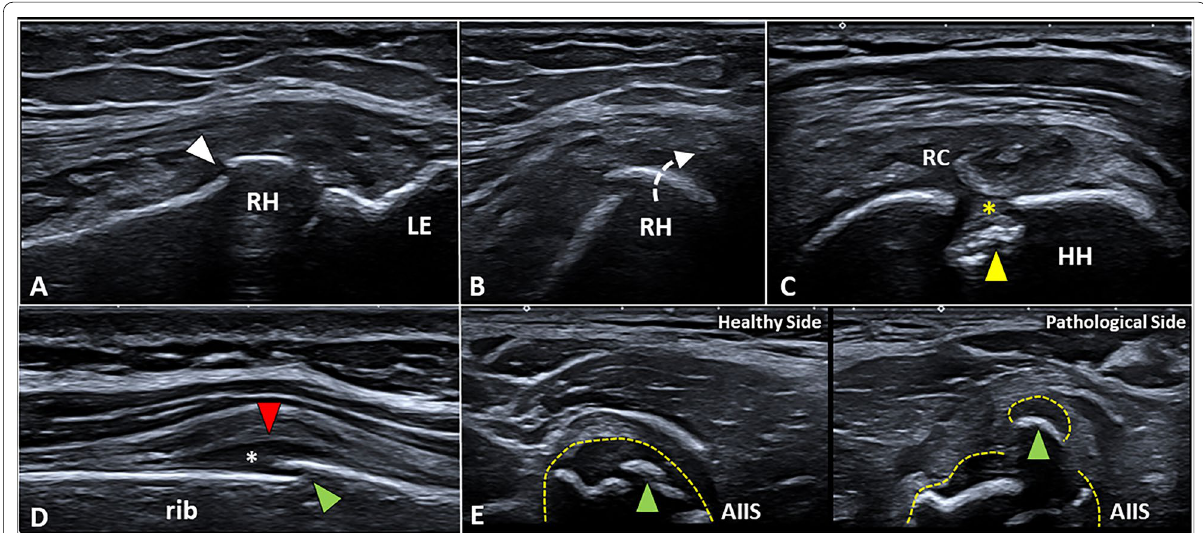
Fig. 4 Impact fractures and avulsion fractures. Longitudinal view ( A ) shows the impact fracture ( white arrowhead ) of the radial head ( RH ), but only by performing the transverse scan ( B ) the degree of rotation ( white dotted arrow ) of the bony fragment can be clearly observed. Likewise, cortical bone depression ( yellow arrowhead ) on the posterior surface of the humeral head ( HH ) — filled with fibrotic tissue ( yellow asterisk ) — can be observed in a patient with previous anterior subluxation of the shoulder ( C ). Unlike the post-acute injuries, in the acute phase of trauma ( D ) the misalignment of the cortical bone ( green arrowhead ) is usually coupled with the periosteal bulging ( red arrowhead ) and subperiosteal hematoma ( white asterisk ). Of note, avulsion fractures in the pediatric population ( E ) can show a simultaneous shifting of the cartilaginous epiphysis ( yellow dotted line ) and the